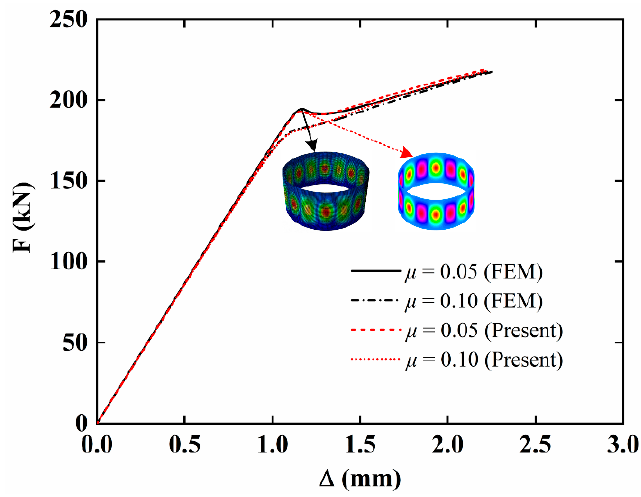
Figure 4. Comparison of load-edge shortening curves of single-layer imperfect NFRC cylindrical shells.